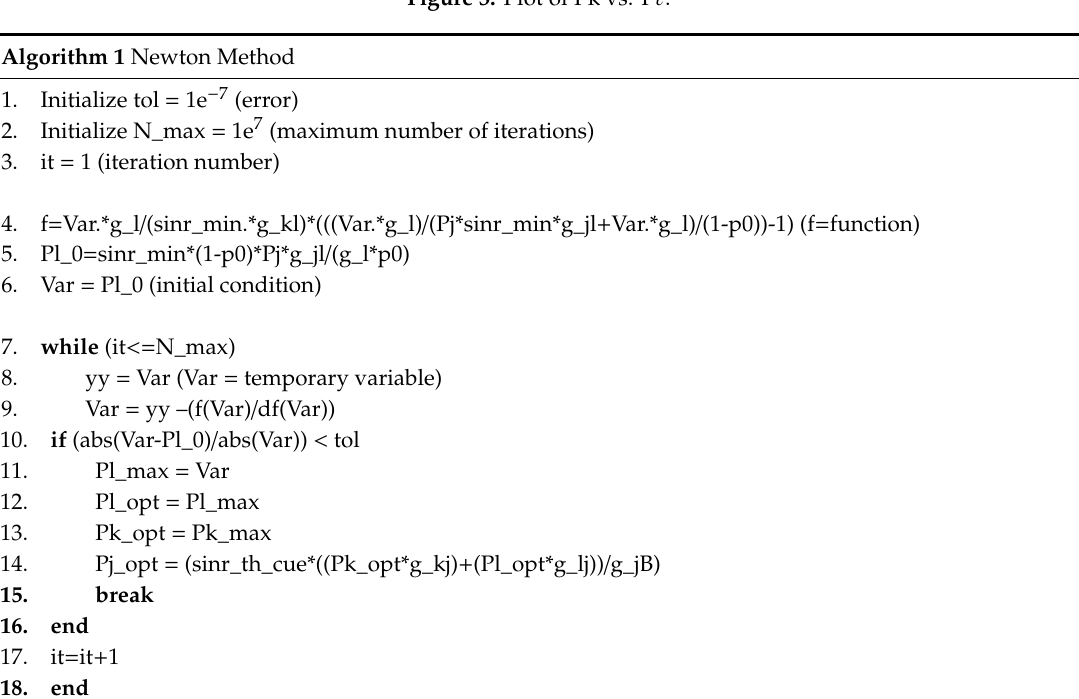
Figure 3. Plot of Pk vs Pℓ .